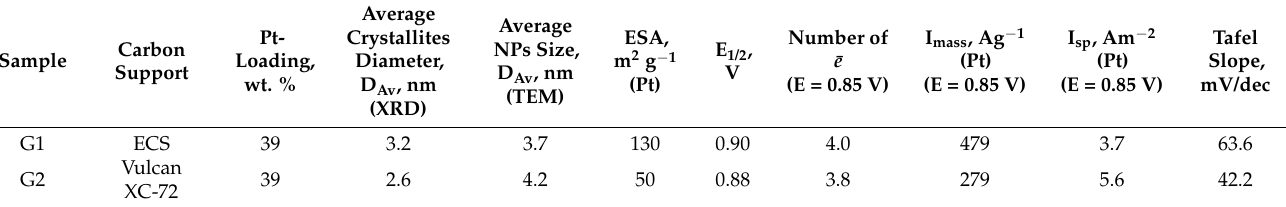
Table 1. Composition, structure, and electrochemical characteristics of Pt/C